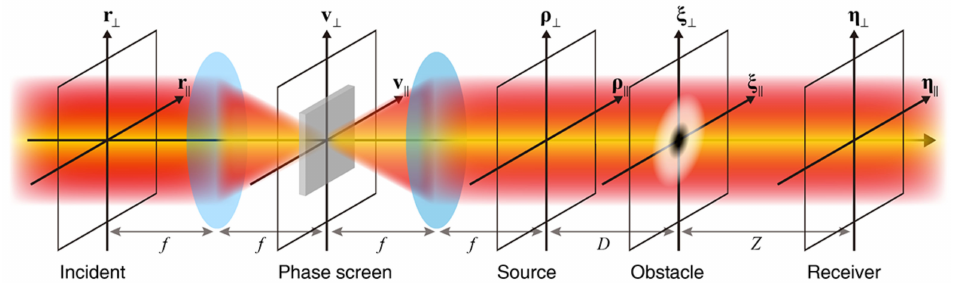
Figure 1. Schematic diagram for the generation of a PCAB via Fourier processing and study of its self-healing property. The system comprises two identical lenses with the focal length f , a phase screen, and one obstacle. All relevant planes and axes are